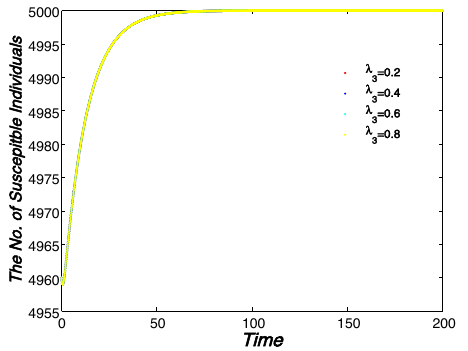
Figure 4. Time evolution of the number of nodes in the S state for various values of the parameter λ 3 : R 0 < 1. Here, λ 1 = 0.25, λ 2 = 0.3, γ 1 = 0.6, γ 2 = 0.7.